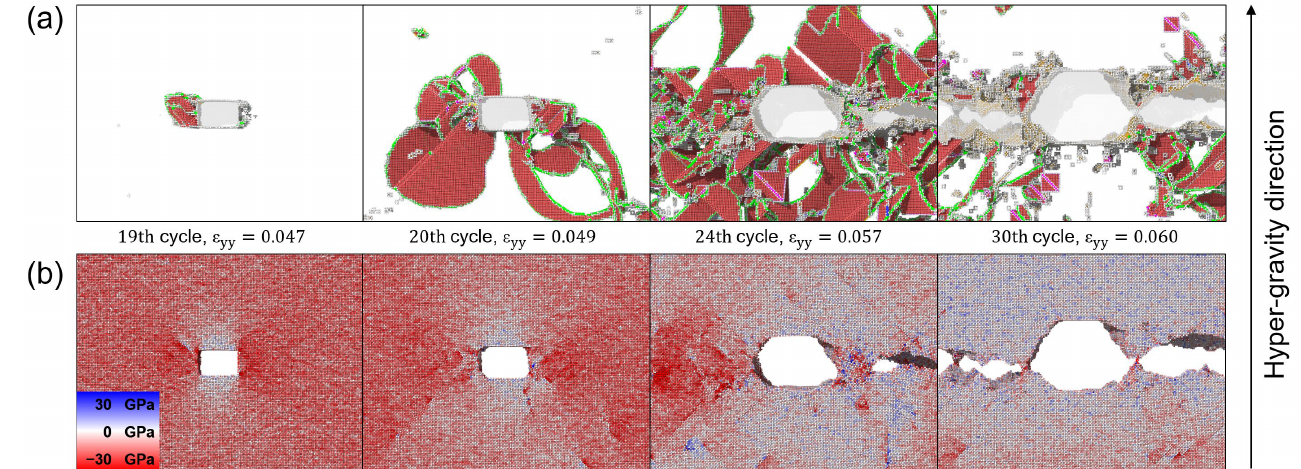
Figure 2. The microstructure evolution of [001](010) crack at 300 K and zero-gravity conditions. ( a ) The red and grey color indicates HCP and unidentified structures, respectively. FCC atoms have been deleted for the clarity of the picture. Dislocations are visualized by using the DXA algorithm. ( b ) atomic stress (τ yy ) distribution at selected cycle numbers.